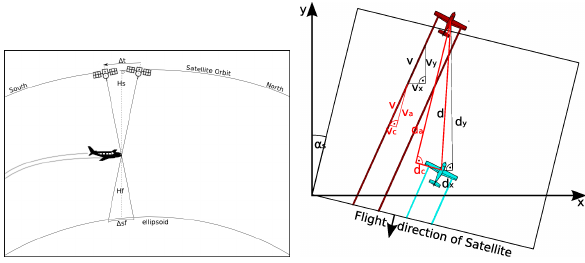
Figure 10: Acquisition geometry of planes in RapidEye imagery, left: side view, right: top view The movement of the plane across the flight direction d c is inde- pendent of the influence of the FPA and therefore only depending on the speed component in this direction and the time lag ∆ t between the bands (we take for all measurements d the red and green band as stated above): d c = v c · ∆ t